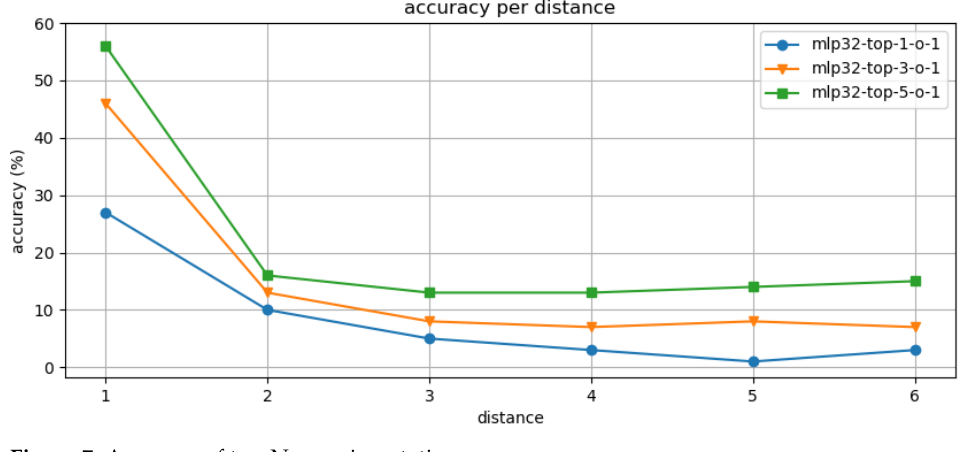
Figure 7. Accuracy of top-N experimentation.